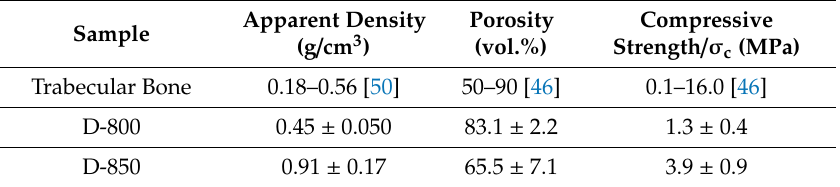
Table 2. Summary of major physical and structural parameters of dolomite-foamed sca ff